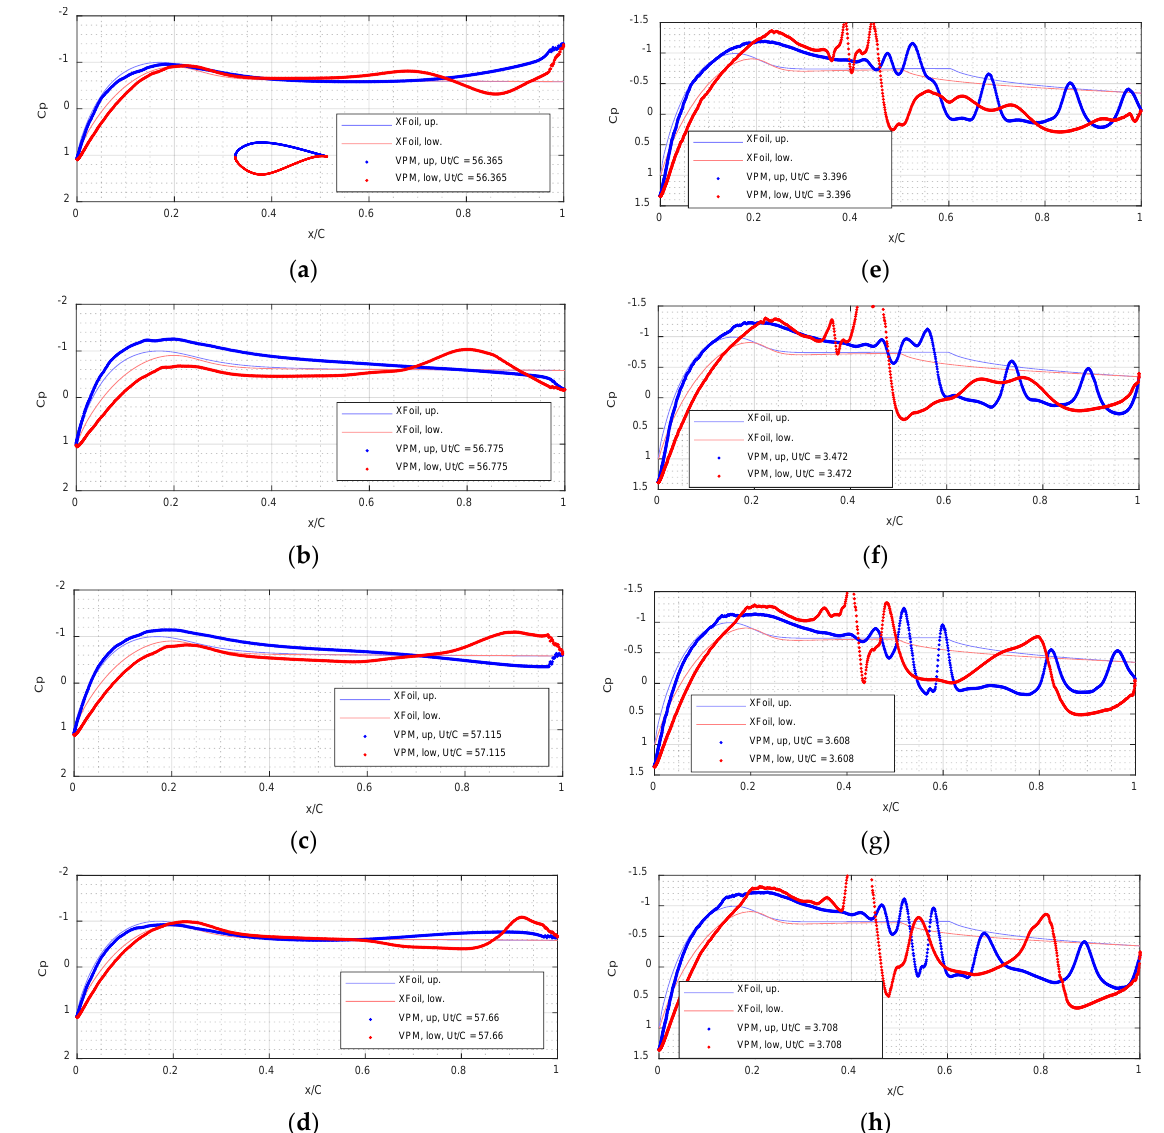
, Rec , Rec = 60,000 and Ut/C = α = 0° α = 0°